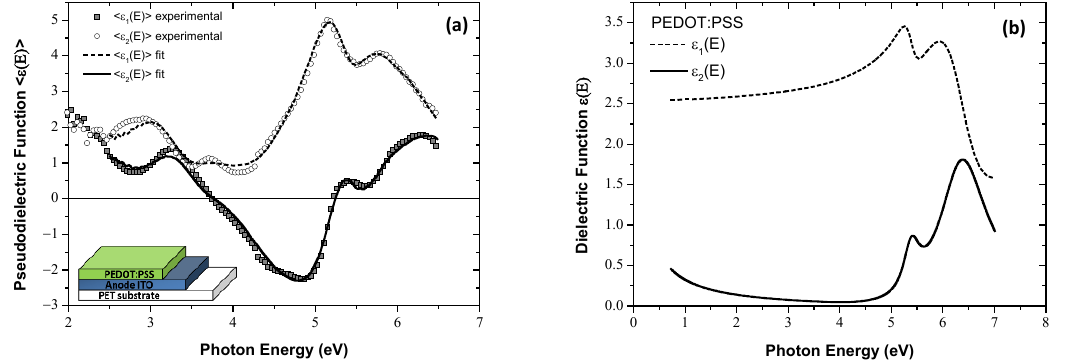
Figure 3. ( a ) The measured SE spectra of the PEDOT:PSS film, grown on PET/ITO (symbols) and the corresponding fitted ones (lines). Inset shows the geometrical structure of the sample. ( b ) The dielectric function ε (E) of the slot-die PEDOT:PSS, calculated using the best-fit parameters derived by SE analysis.